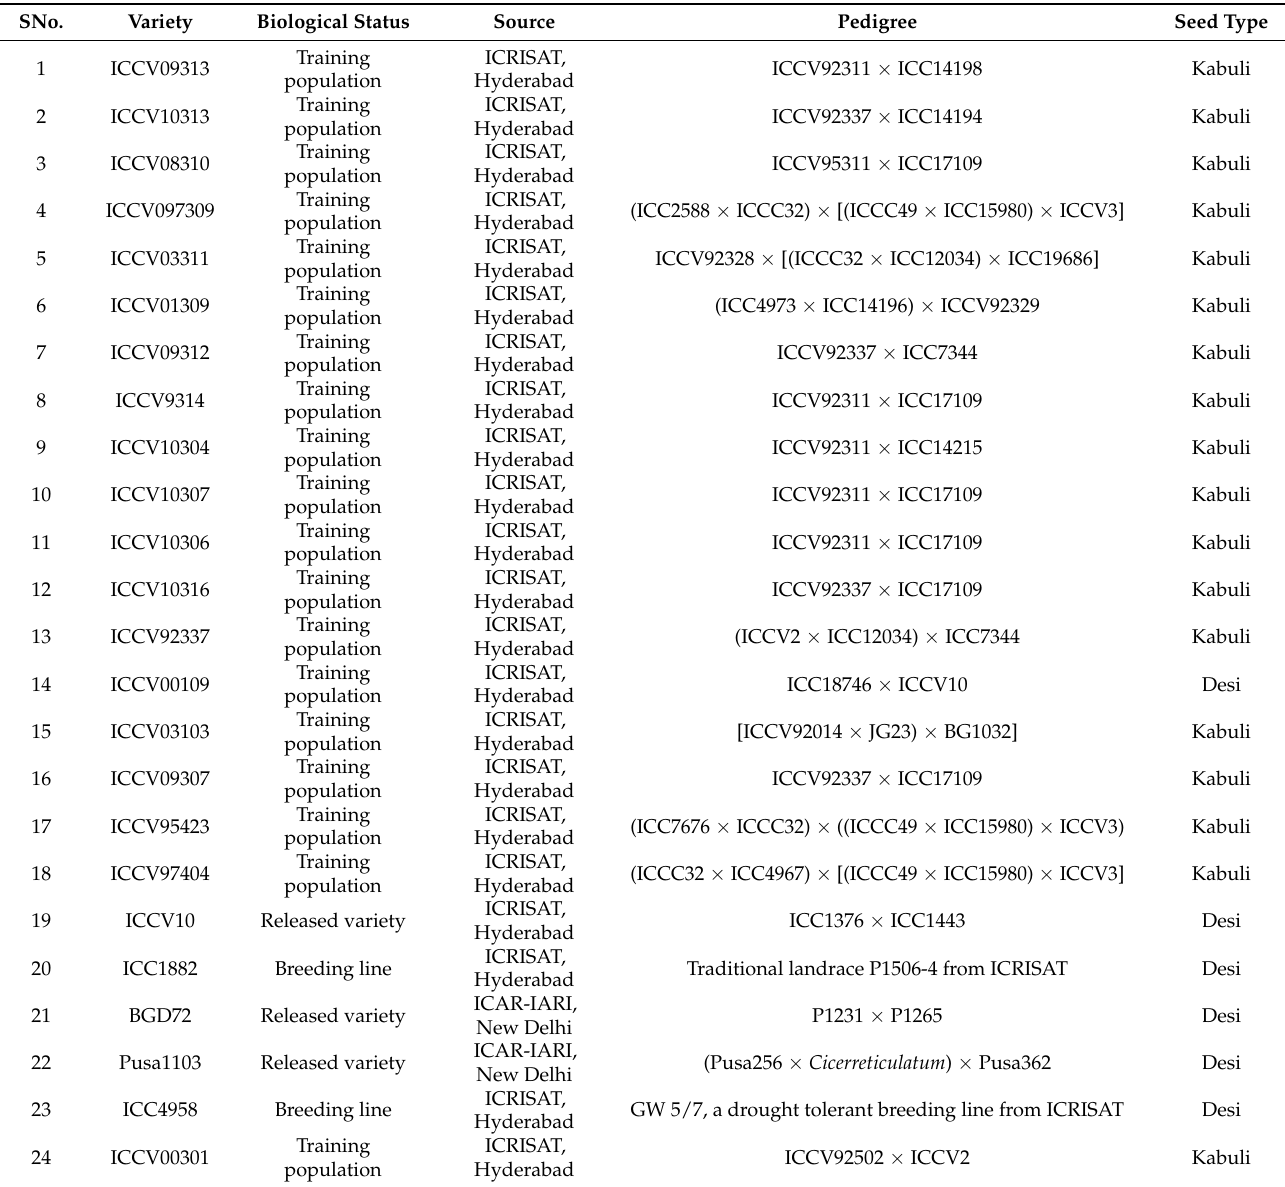
Table 1. List of chickpea